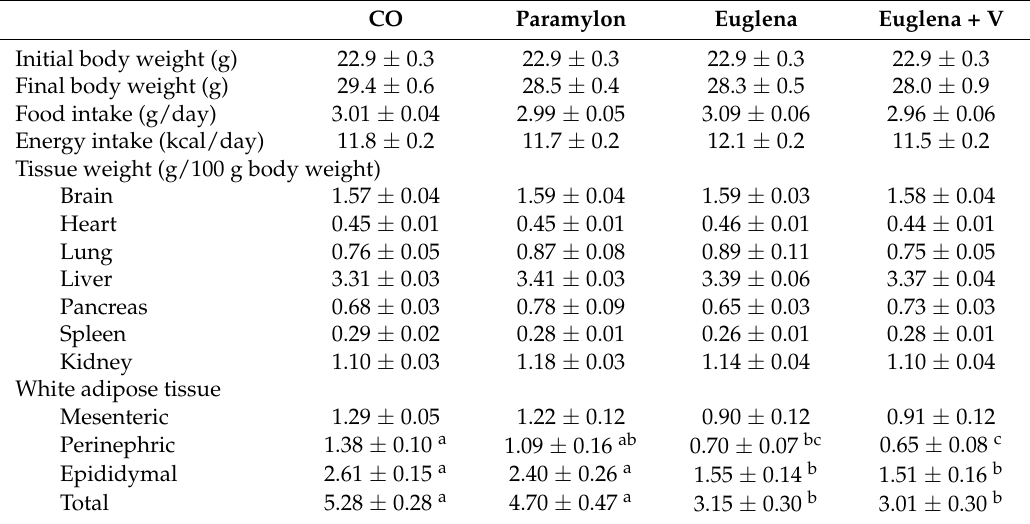
Table 3. Body weights, food intake and tissue weights.